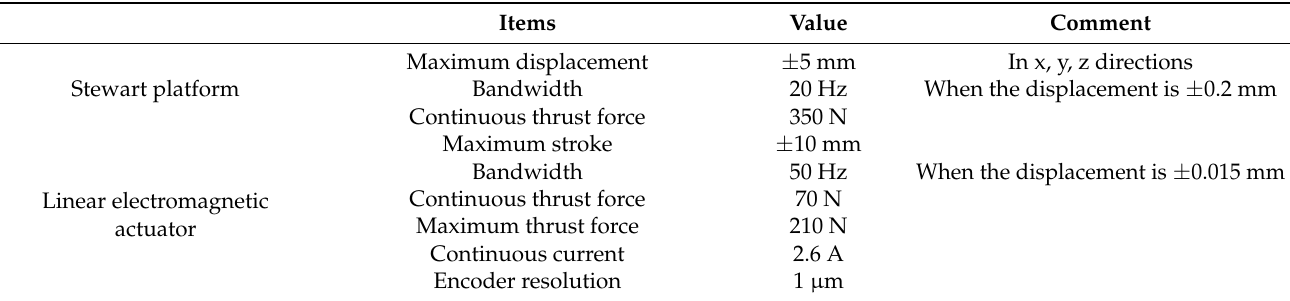
Table 2. Details of the Stewart platform.